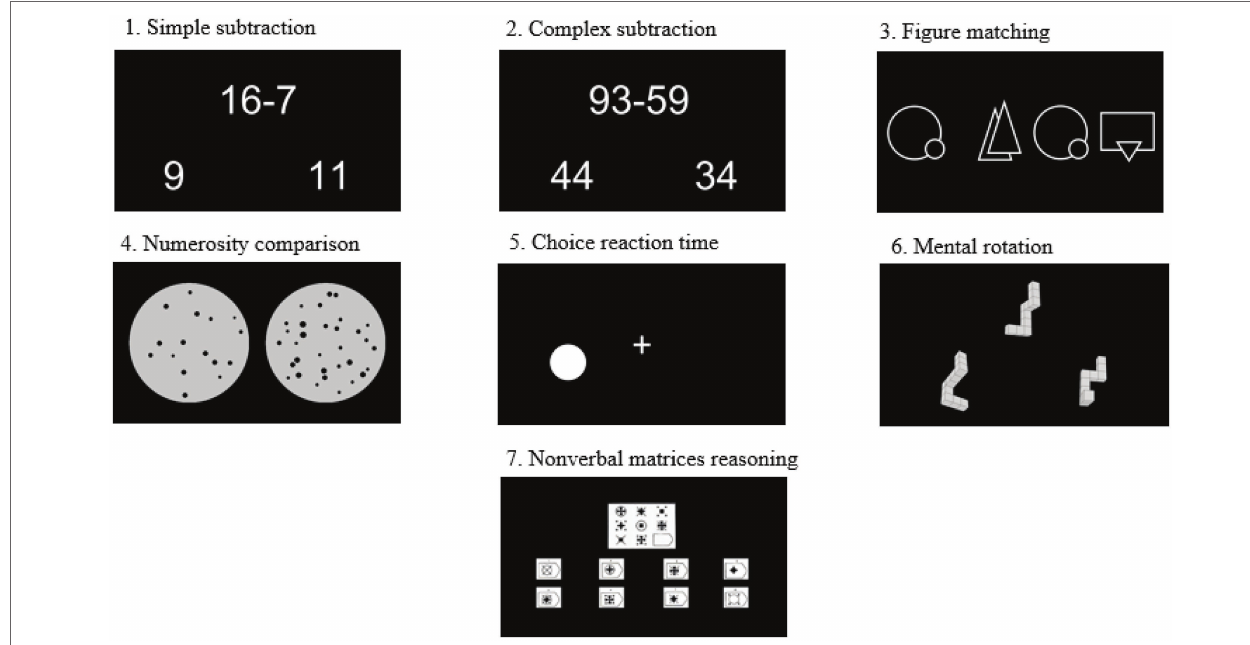
FIGURE 1 | Example of stimuli for all